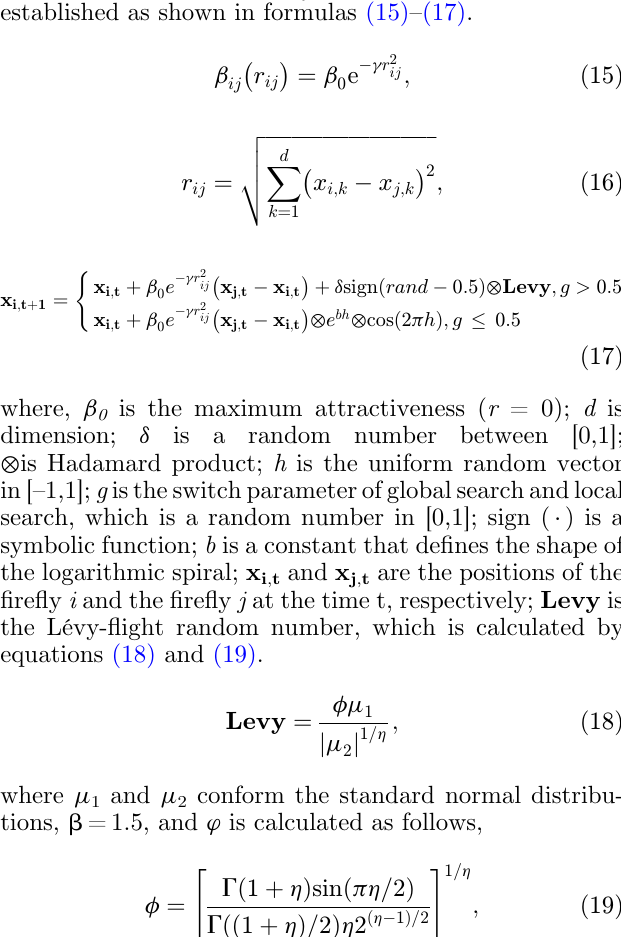
experimental data are depicted in Figure 5. Dashed lines represent experimental data and solid lines forecast data.